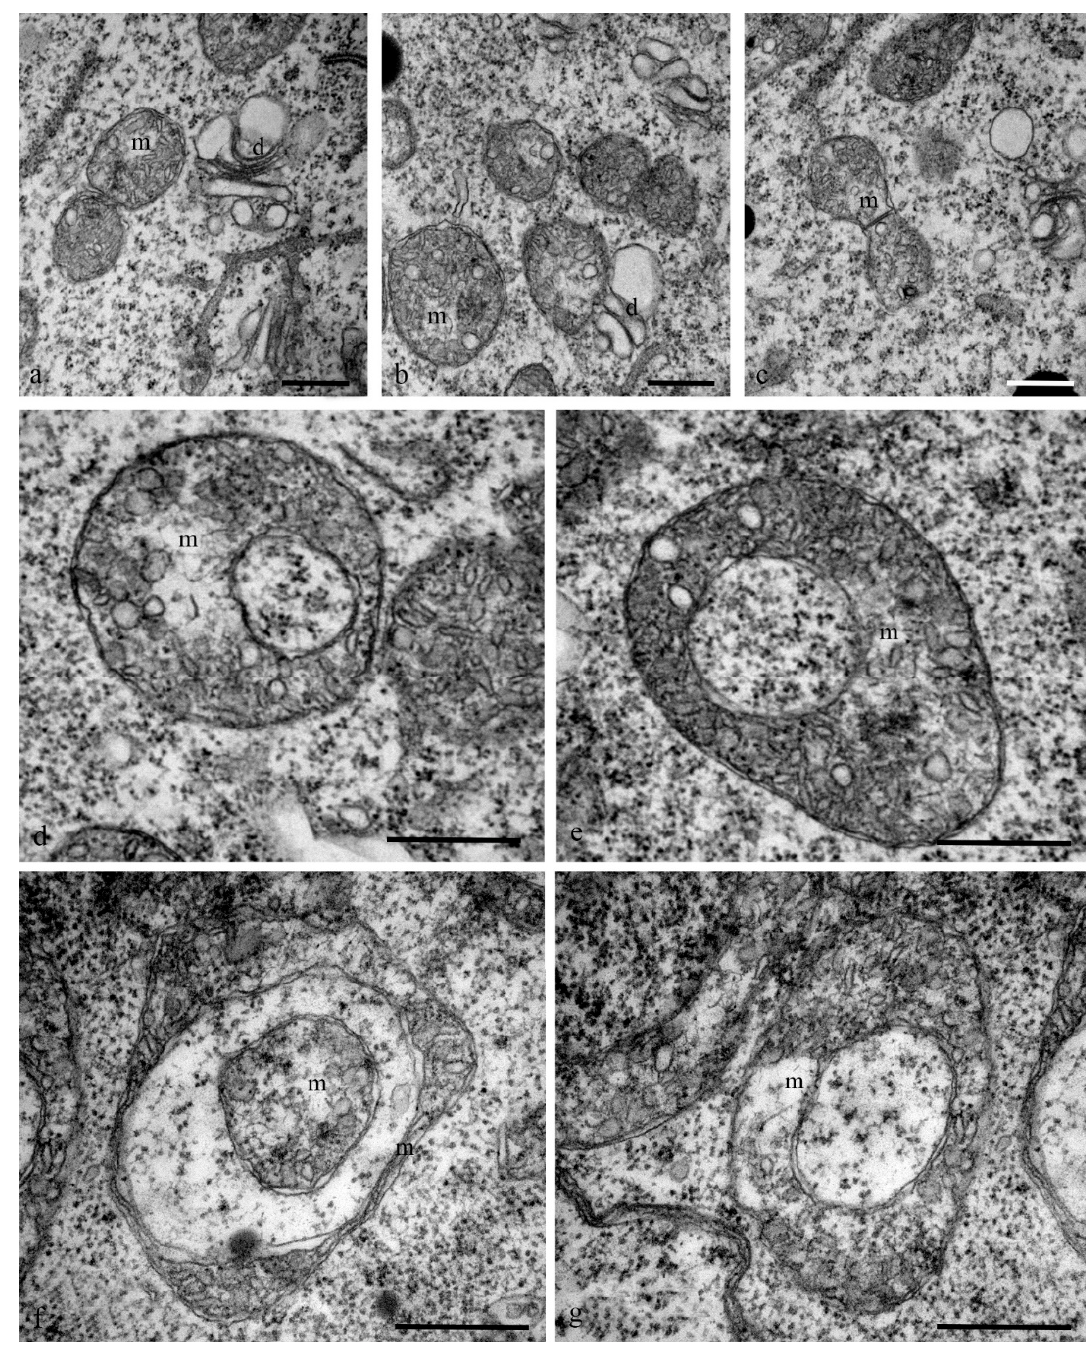
Figure 9. Ultrastructure of the mitochondria of the cytoplasm of the antipodal cells of the wheat embryo sac. All mitochondria of the antipodal cells have finger-shaped, disordered cristae. At the early stages of differentiation, mitochondria are round with a diameter from 0.5 to 1 µm ( a – c ), cup-shaped mitochondria with a diameter of 1 µm ( d , e ) are evident, and cup-shaped mitochondria ( f , g ) are more often detected during PCD. m—mitochondria; d—dictyosomes. The scale is 500 nm. At the early stages of complex development, the leucoplasts (plastids) of antipodal cells acquired a diverse shape: ring-shaped with constrictions and cup-shaped areas were evident (Figure 10). Several lamellae, starch grains, and later, small plastids with a dark stroma and a small number of starch grains, were